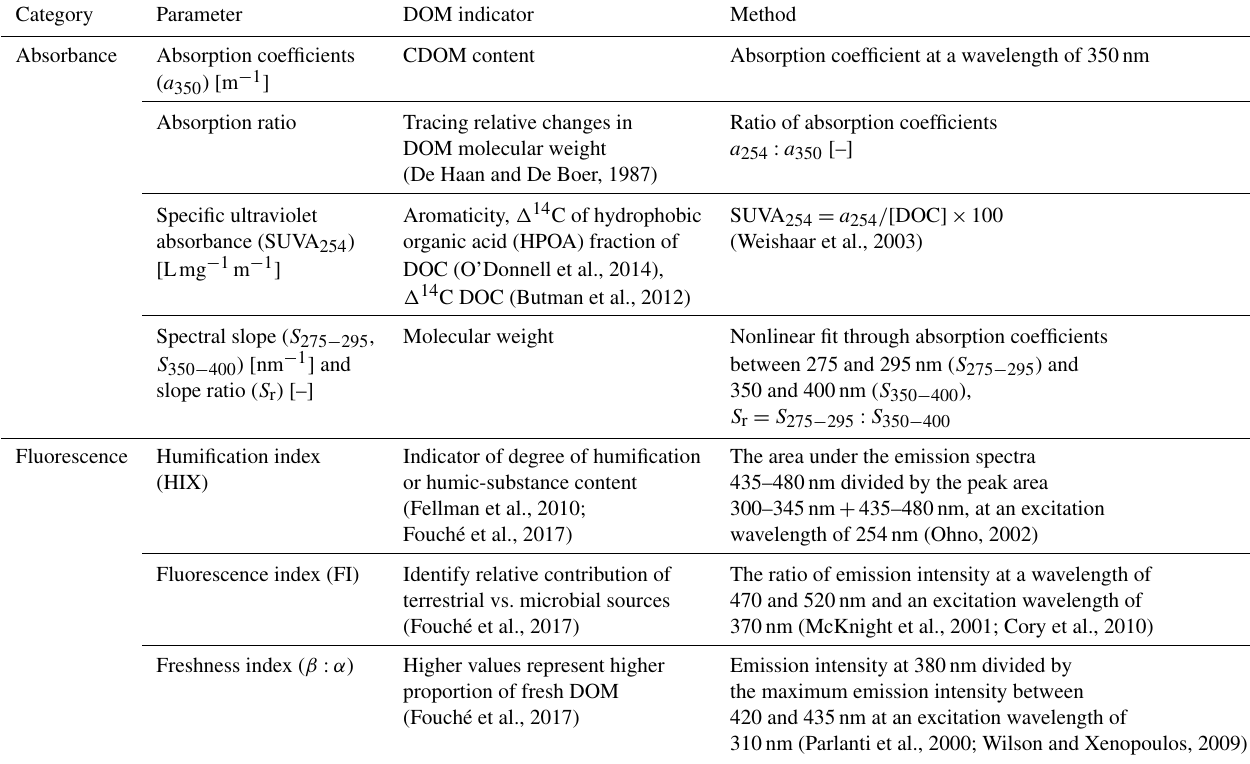
Table 1. Overview of spectral (absorbance and fluorescence) indices used for DOM qualification.